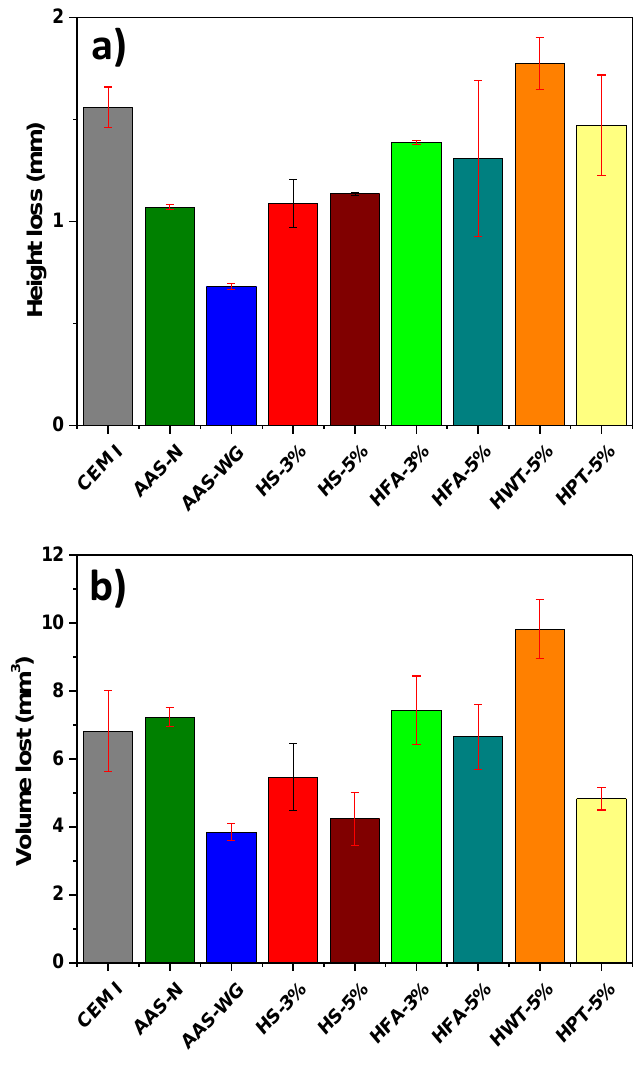
Figure 5. ( a ) Height loss in different mortars studied after wear test; ( b ) lost volume after the wear test (Böhme test) in all systems evaluated. Table 4. Density of all systems evaluated at 28